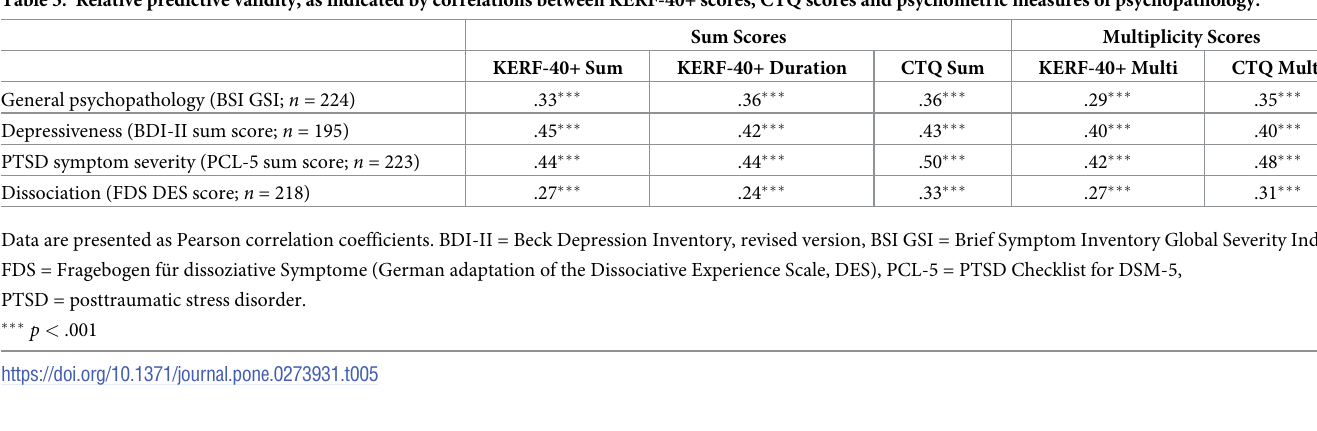
Sexual Abuse by Others Not Living in the Same Household (SEXA-O) The correlations between the corresponding KERF-40+ and CTQ subscales are presented as Pearson correlation coefficients. CTQ = Childhood Trauma Questionnaire. ROC = Receiver operating characteristic.